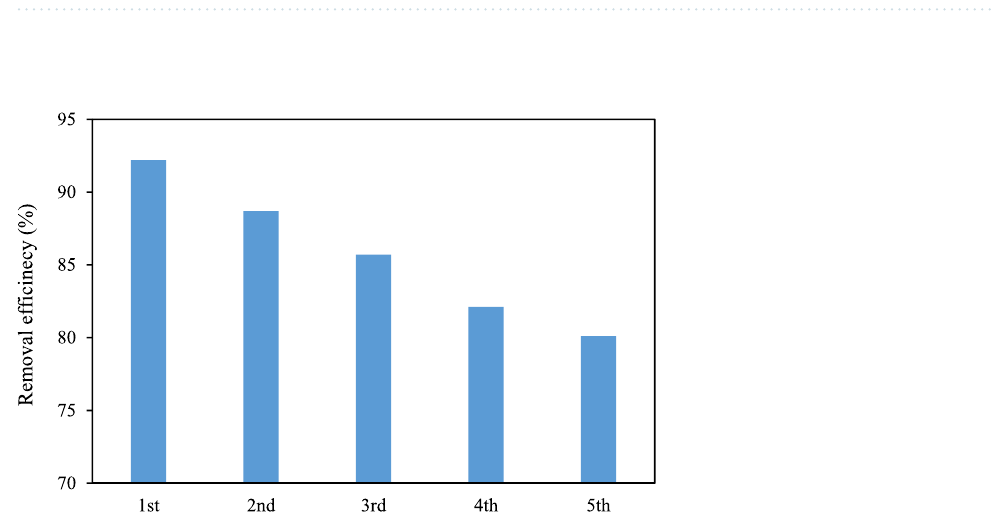
Figure 12. Reusability test for the MSW compost